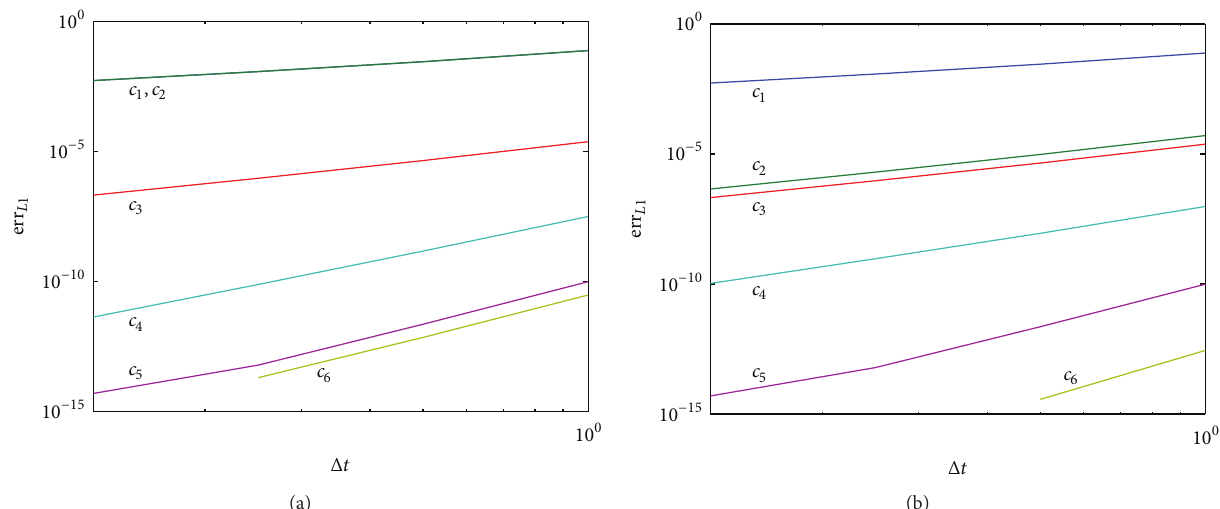
Figure 5: Numerical errors of the one-sided and two-sided splitting schemes for an optimised approach: one-sided splitting over 𝐴 (a) and two-sided splitting scheme alternating between 𝐴 and 𝐵 (b) with 1, ...,6 iterative steps.